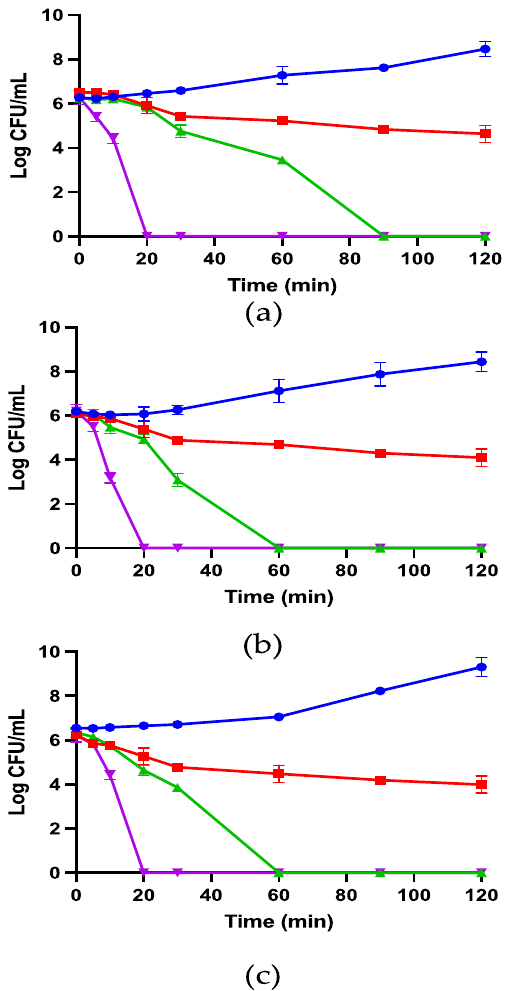
Figure 5. The kinetic time-killing curves of kunitzin-OV 2 ( a ), TAT-KOV 2 ( b ), and TAT-F9-KOV 2 ( c ) against E. coli at the concentrations of 1/2 × MIC (red), 1 × MIC (green), 2 × MIC (purple), and the growth control (blue) with no peptide added. Y-axis represents log CFU/mL for all groups, which is determined at time 0 and at subsequent time points up to 120 min. The error bar represents the SEM of nine replications in three experiments.